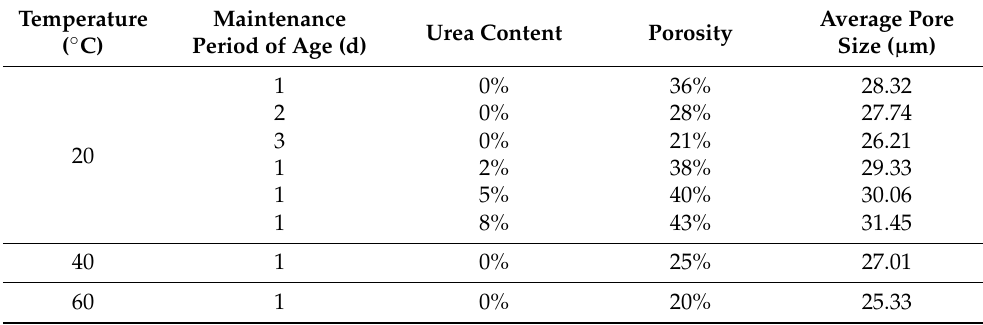
Table 6. Porosity and average pore size of net cement paste under different conditions.